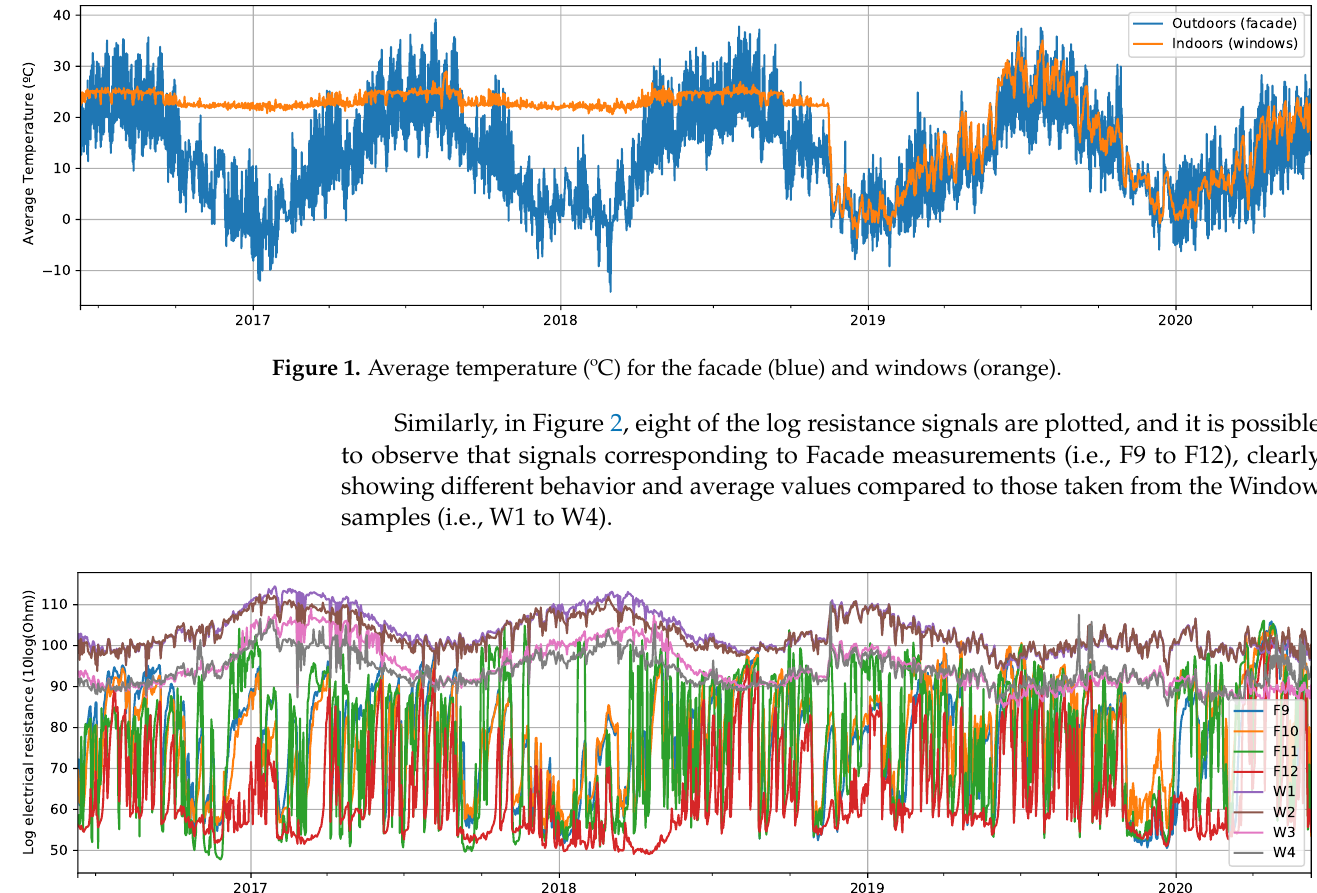
Figure 2. Log electrical resistance (10log Ω ) for four of the Facade signals (F9 to F12) and for the four signals only from the Windows (W1 to W4). Daily averages were taken to facilitate